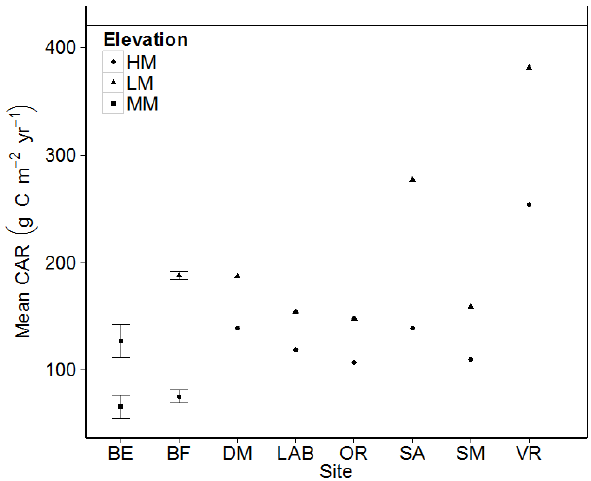
Figure 5. CAR of salt marshes in relation to habitat elevation from low marsh to mid- or high marsh. Different symbols for CAR of low, mid- and high-marsh locations from the same site were aligned ver- tically. BE – the Blackwater Estuary, UK; BF – the Bay of Fundy, New Brunswick, Canada; SM – Stiffkey Marsh, UK; DM - Dengie Marsh, UK; SA - St. Annaland, Netherlands; OR – Oder River, Poland; VR – Vistula River, Poland; LAB – Little Assawoman Bay, USA; HM – high marsh; MM – mid-marsh; LM – low